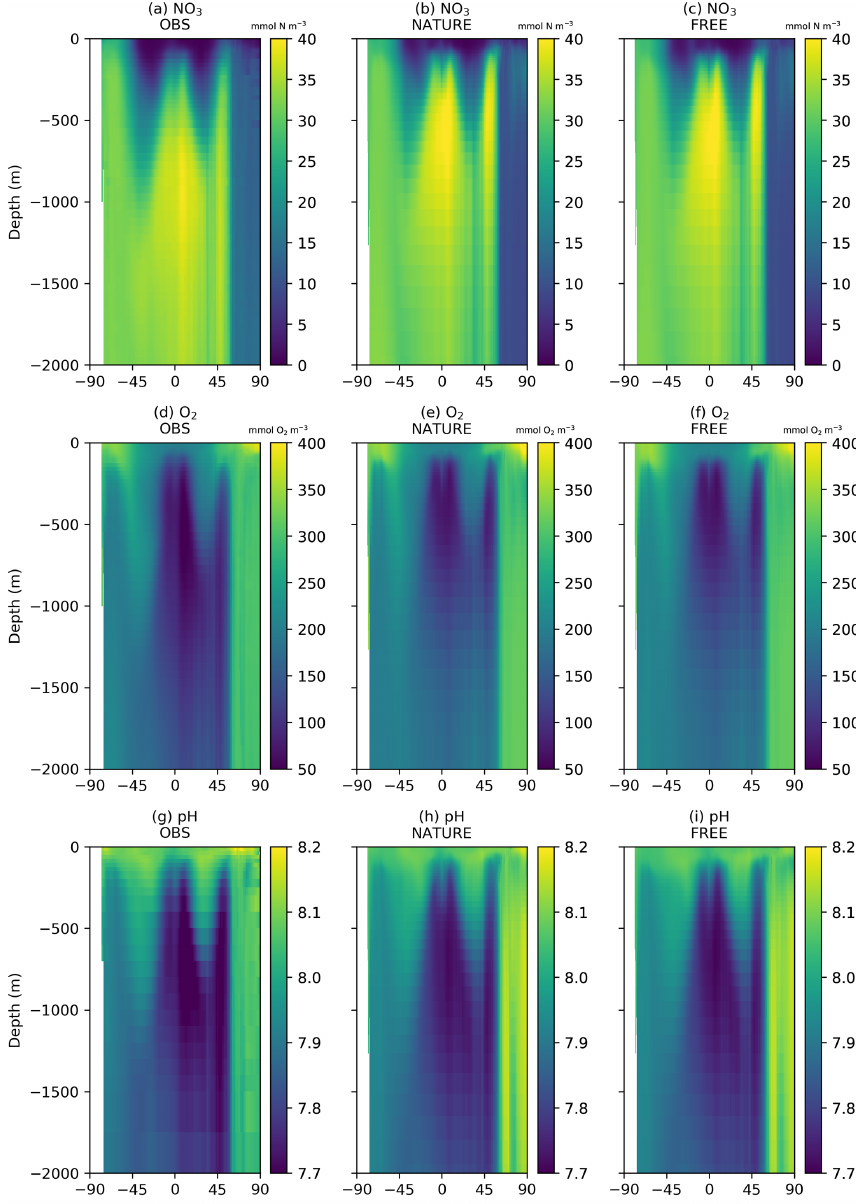
Figure 4. Annual zonal mean sections of (a–c) NO 3 , (d–f) O 2 , and (g–i) pH from real-world observation-based products (a, d, g) , NA- TURE (b, e, h) , and FREE (c, f, i)